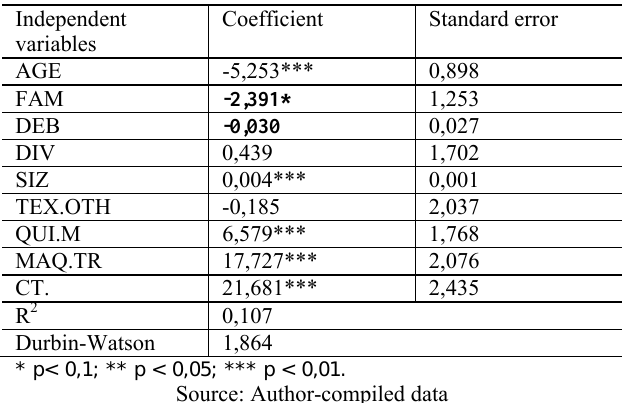
Table 11: ANOVA OLS Sum of squares gl RMS F